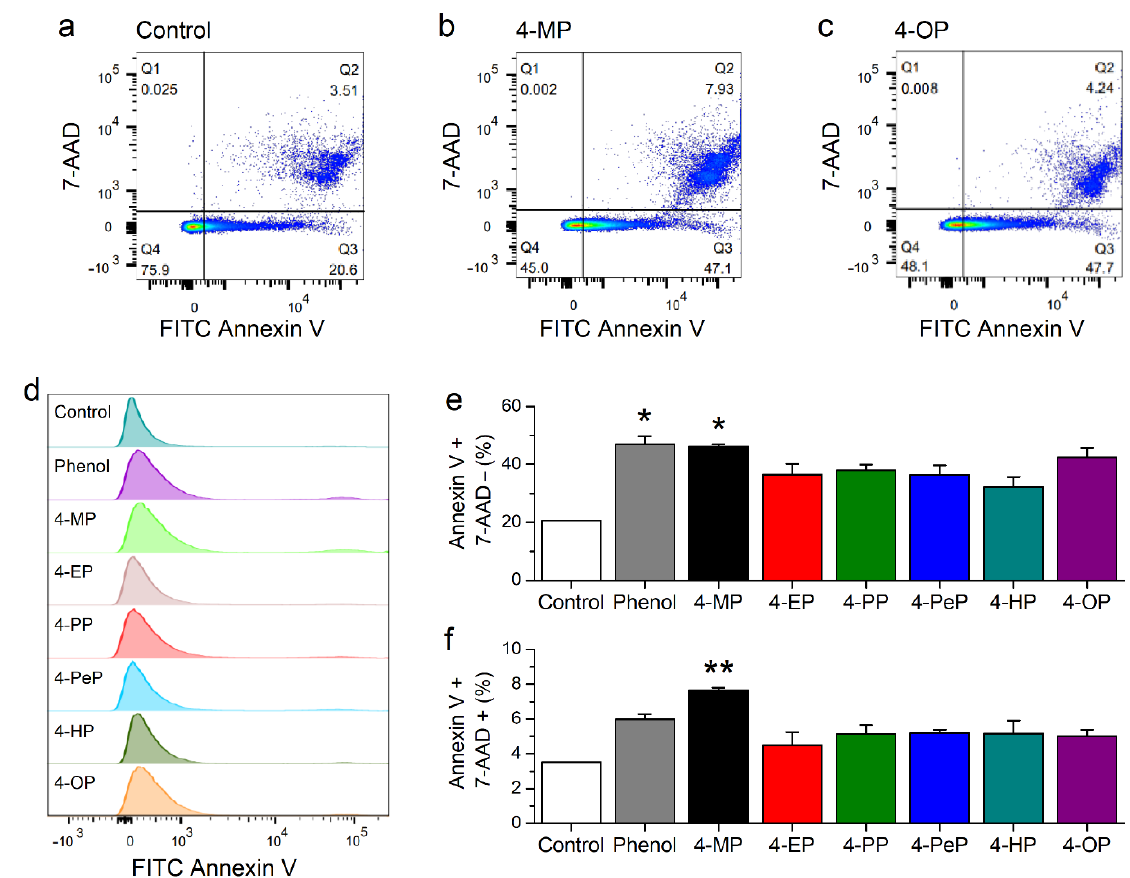
Figure 9. Alkylphenols induced lipid reordering in the plasma membrane. ( a – c ) Representative fluorescence-activated cell sorting (FACS) scatter plots of 7-ADD vs Annexin V-FITC obtained in CHO-mTRPA1cells after 10 min in control condition ( a ) and incubation with 1300 µ M of 4-MP ( b ) and 5 µ M of 4-OP ( c ). The quadrants Q1, Q2, Q3, and Q4 indicate cells labeled Annexin V-negative/7-AAD-positive, Annexin V-positive/7-AAD-positive, Annexin V-positive/7-AAD-negative and Annexin V-negative/7-AAD-negative, respectively. The numbers indicate the respective percentages of total cell population. ( d ) Representative histograms of Q3 (Annexin V-positive, 7-AAD-negative). ( e , f ) Average of percentages of Annexin V-positive/7-AAD-negative ( e ) and Annexin V-positive/7-AAD-positive ( f ); * p < 0.05, ** p < 0.01, n = 3, t test.